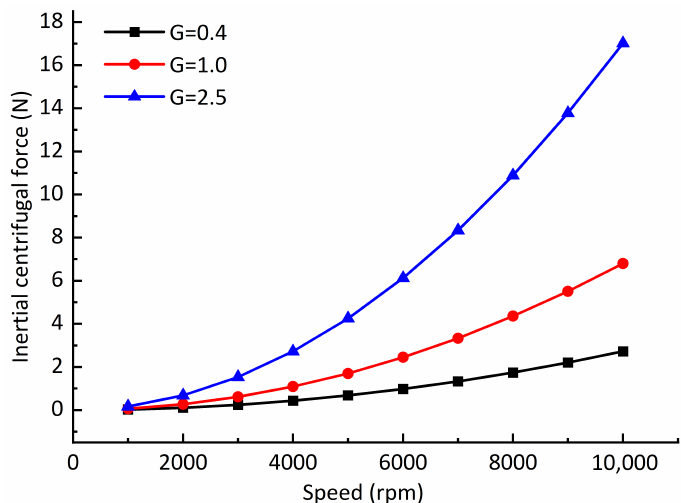
Figure 15. Unbalanced force at different dynamic balancing